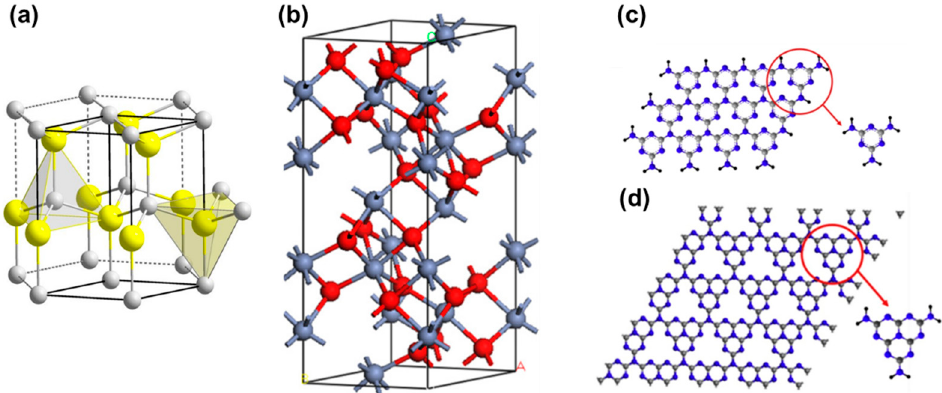
Figure 7. Atomic structure of typical photocatalysts for photodegradation. ( a ) ZnO wurtzite cell, Zn atoms in yellow, O atoms in grey [51]. ( b ) The hexagonal representation of unite cell of ferric oxide (hematite) with Fe atoms in blue and O atoms in red [52]; reprinted from [52] with permission from IOP Publishing. Structure of ( c ) s-triazine and ( d ) tri-s-triazine as the primary building blocks of graphitic carbon nitride with C atoms in grey and N atoms in blue [50]; reprinted from [50] with permission from Elsevier.